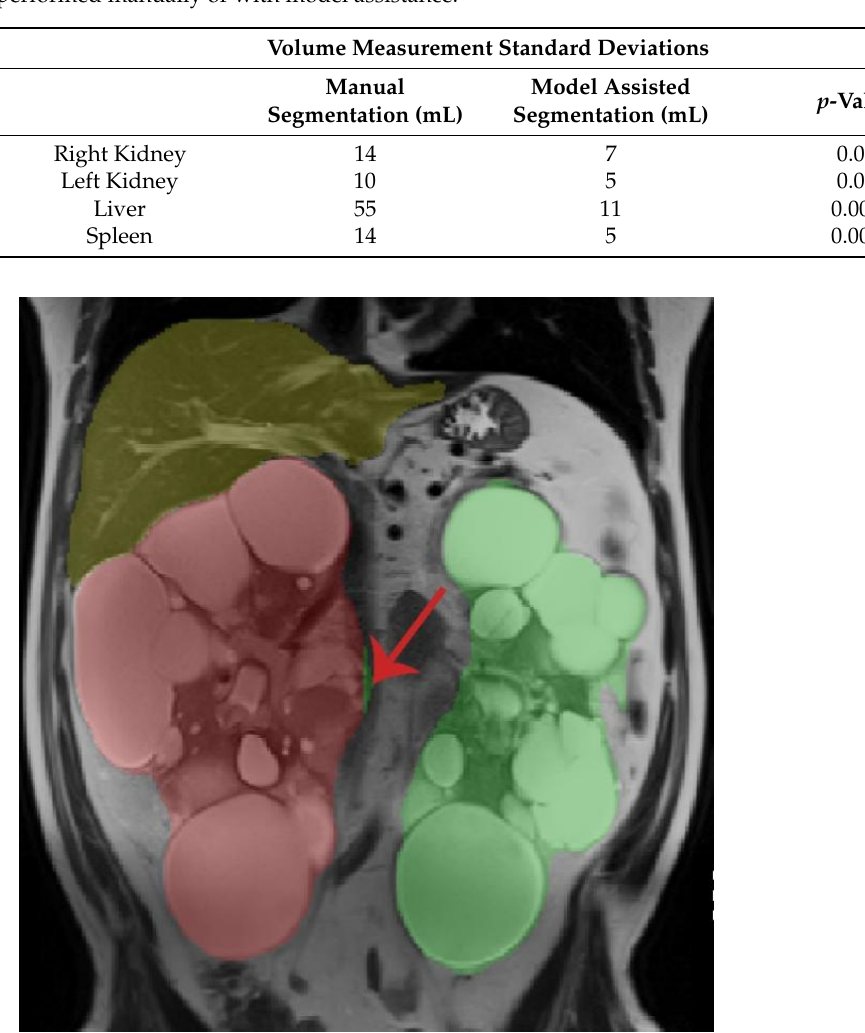
Table 5. Standard deviations of organ volumes measured by three trained observers for segmentations performed manually or with model assistance.